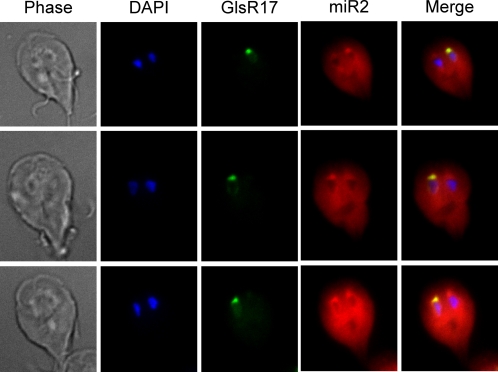
Localization of GlsR17 and miR2 in Giardia using FISH.GlsR17 is predominately localized to a single nucleus with a focus in the putative nucleolus in each Giardia trophozoite. miR2 is localized primarily to the cytoplasm.